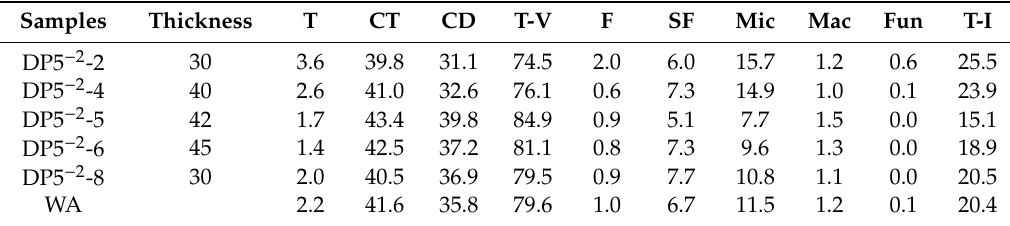
Table 2. The maceral contents of the coal samples from Dongpo Mine determined using optical microscopy (Vol. %; on a mineral-free basis).